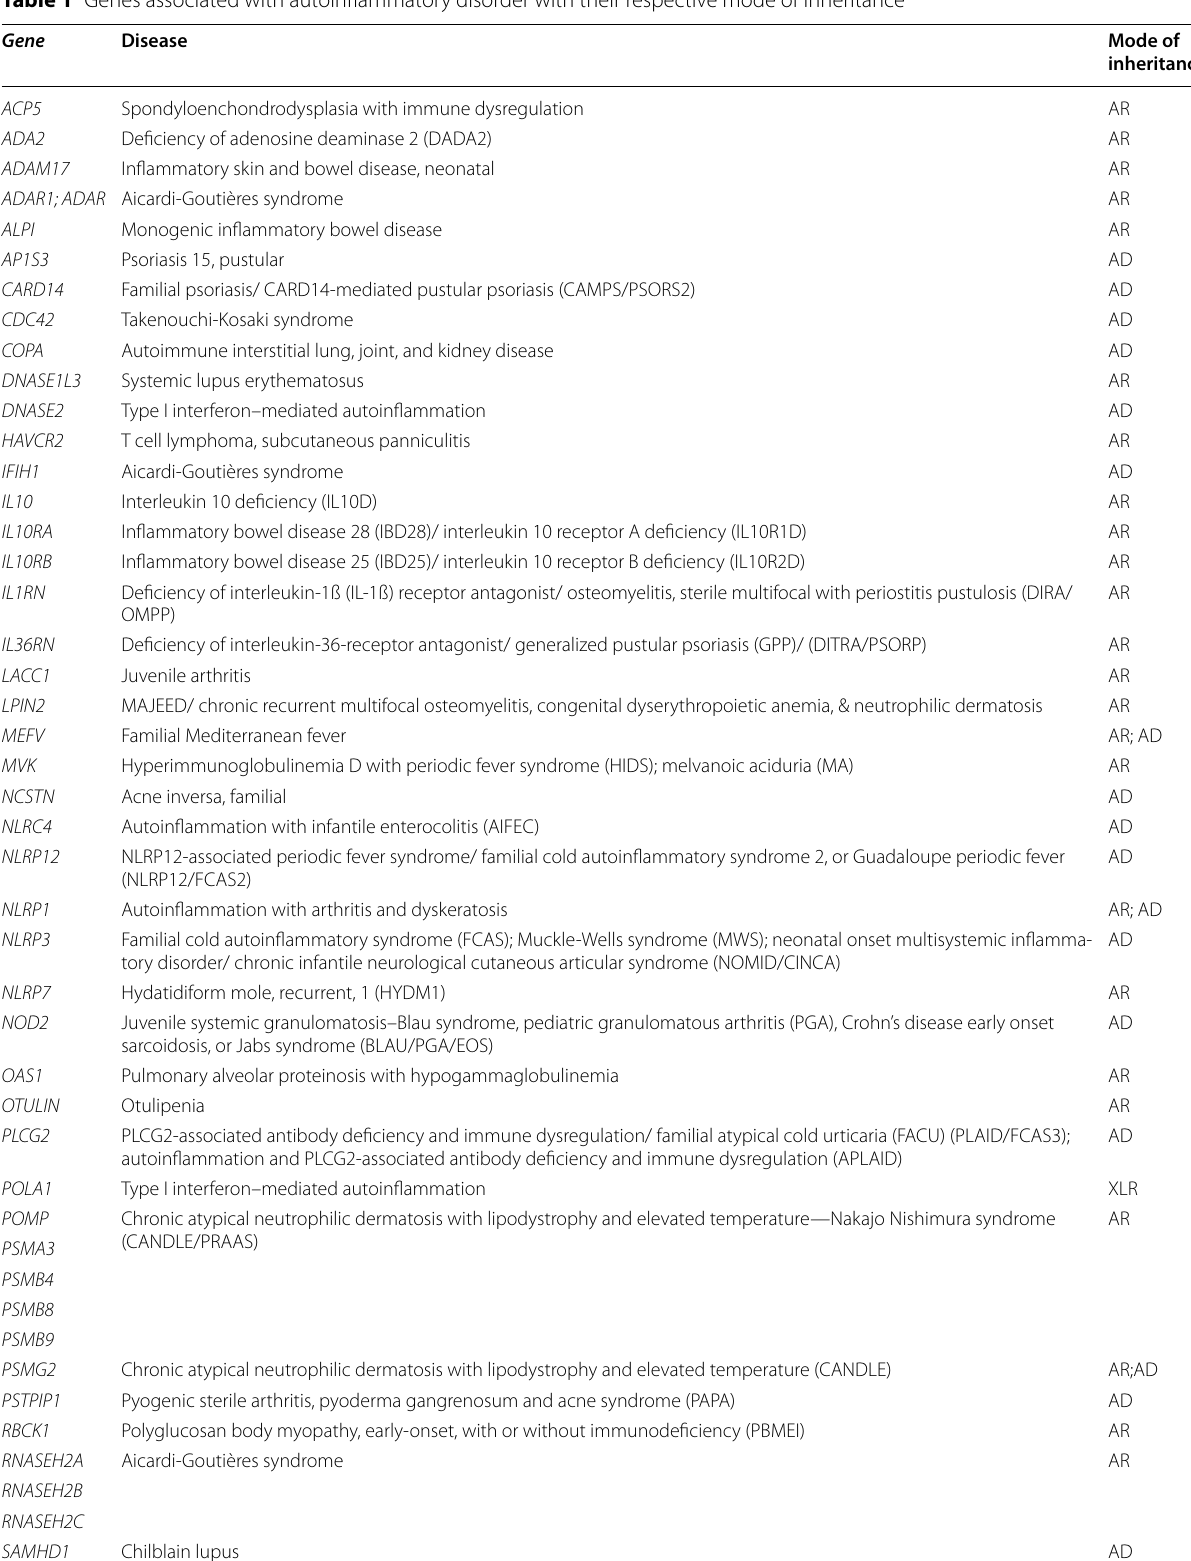
Table 1 Genes associated with autoinflammatory disorder with their respective mode of inheritance Gene